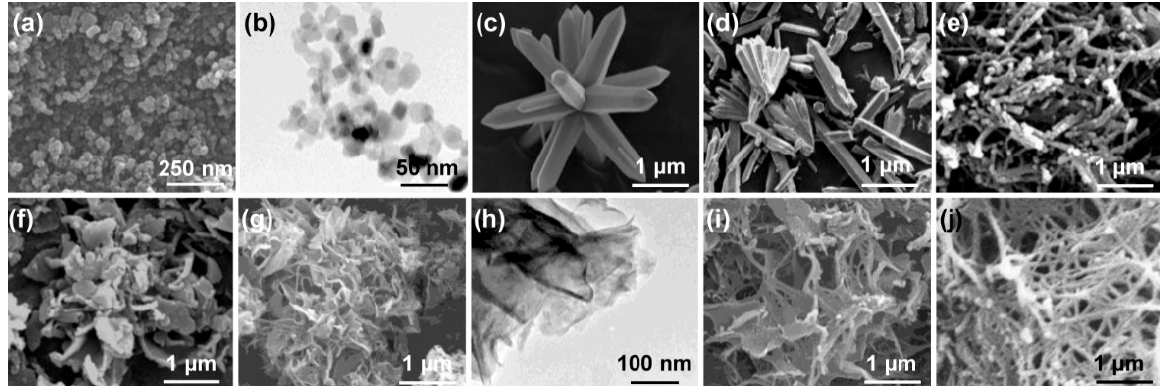
Figure 2. FESEM images of ( a ) P25, ( c ) Zn-4, ( d ) Zn-5, ( e ) Ti-5, ( f ) Zn-Ti-5, ( g ) Zn-Ti-6, ( i ) Zn-Ti-7, and ( j ) Zn-Ti-8; TEM images of ( b ) P25, and ( h ) Zn-Ti-6.